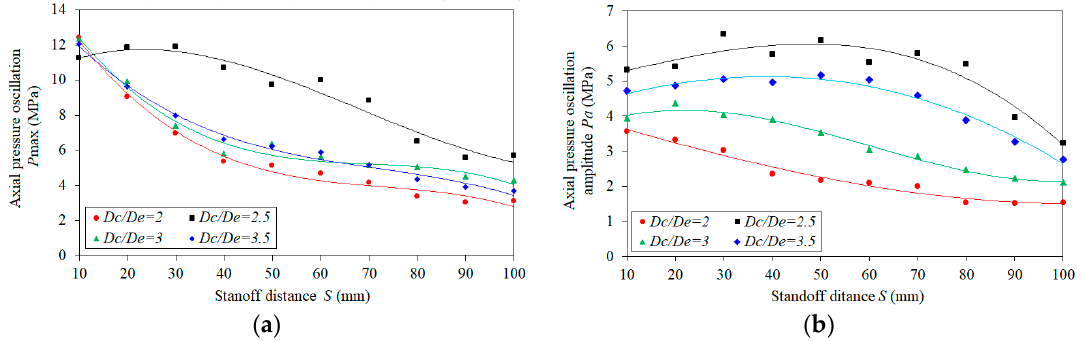
Figure 4. The axial pressure oscillation ( a ) peak and ( b ) amplitude against the standoff at an inlet pressure of 10 MPa.